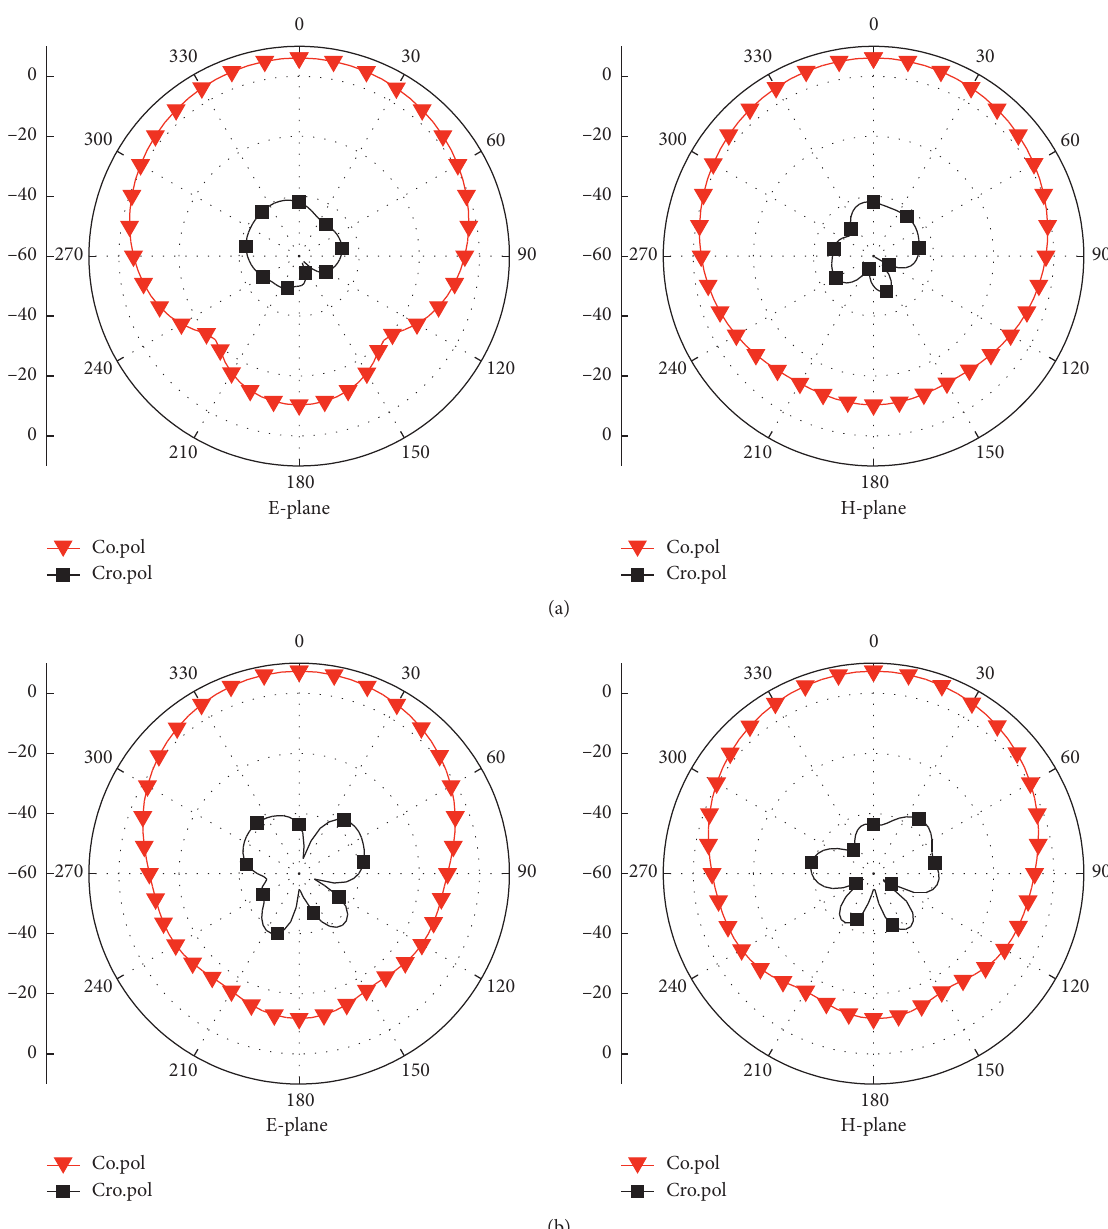
Figure 9: Simulated radiation patterns of the antenna at two different frequencies. (a) 3.5GHz; (b) 5